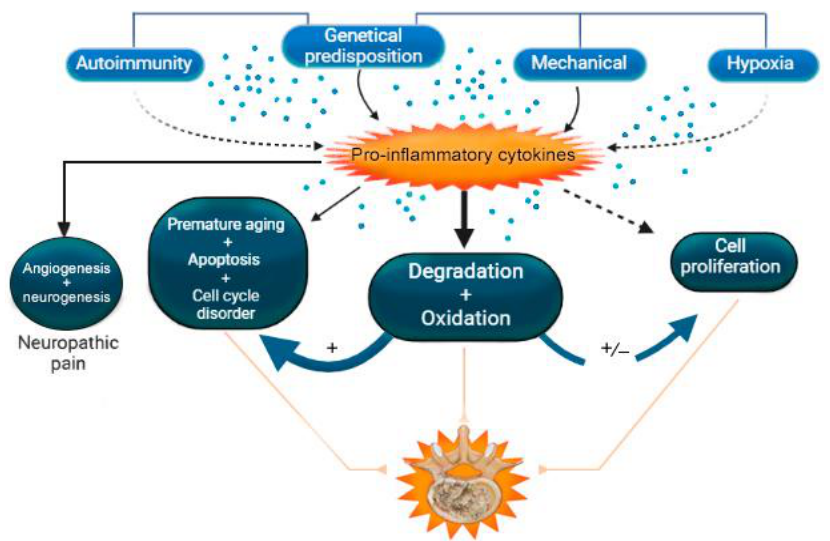
Figure 2. Effects of pro-inflammatory cytokines in intervertebral disk degeneration (IDD). Note: (+)— relationship between the mechanisms of IDD development; (+/ − )—possible relationship between the mechanisms of IDD